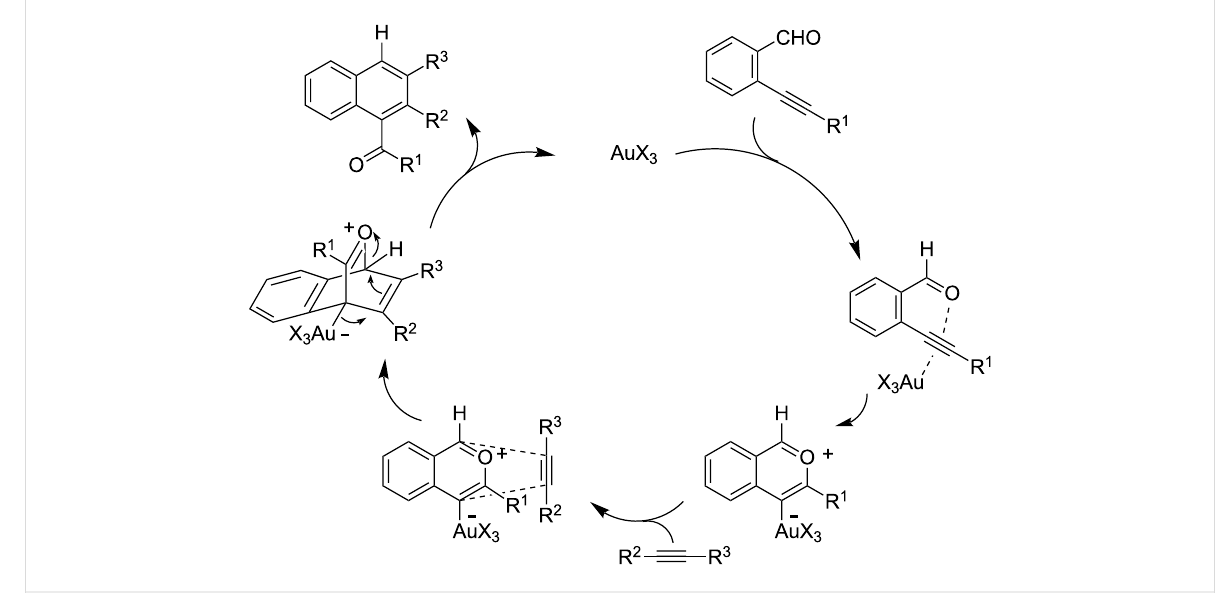
Figure 1: Mechanism of Au(III)-catalyzed benzannulation between aromatic carbonyls and